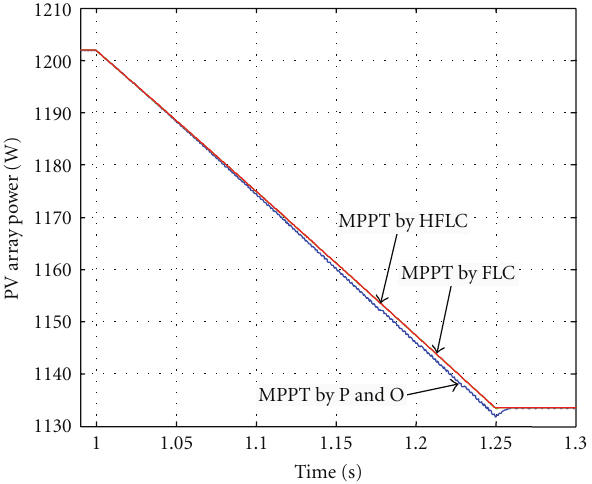
Figure 19: PV output power under slow temperature change from 25 ◦ C to 50 ◦ C.